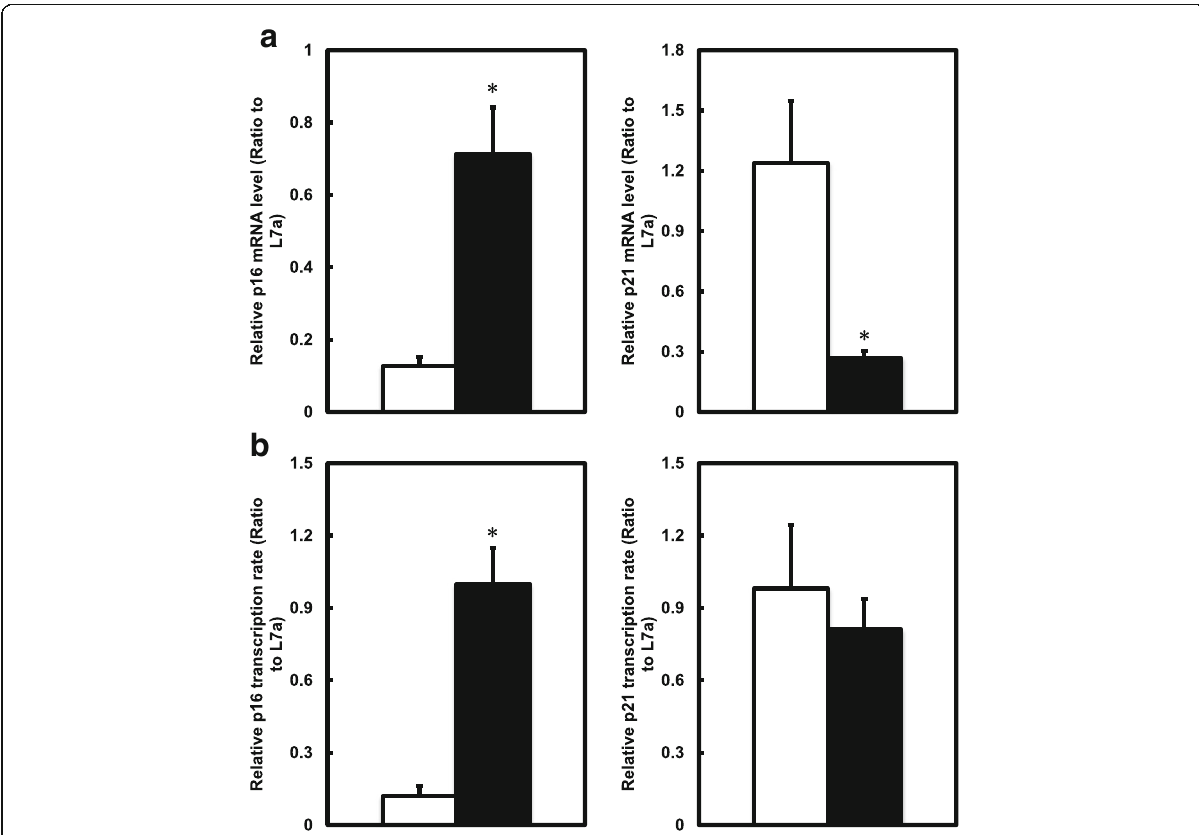
Fig. 3 Effects of different diets on hepatic cellular senescence genes in male rats. a p16(INK4a) and p21(Cip1) mRNA level in C and HF rats as determined by quantitative real-time PCR. Data are presented in arbitrary units as relative mRNA abundance normalized to rL7a transcript abundance ( n =10). Values are mean ± SEM, P <0.05*. b p16(INK4a) and p21(Cip1) transcription rate under different maternal diets in male offspring rats as determined by quantitative real-time PCR ( n =10). Values are mean ± SEM, P